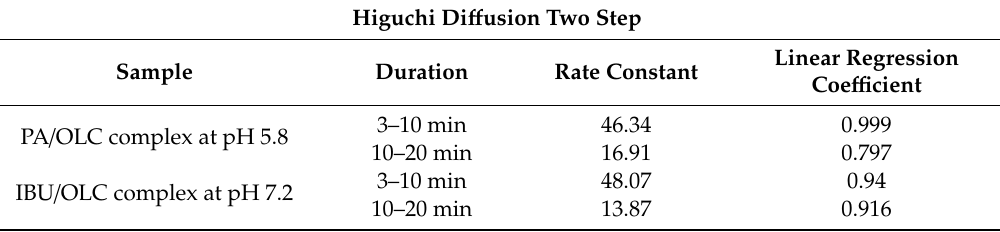
Figure 8. Two step regression linear utilising Higuchi’s square root of time plot for drug release from complex in the presence of SDS. In brackets pH of the dissolution medium. Each point represents the mean of n = 3 determinations. Table 2. Kinetic parameters of drug release from paracetamol and ibuprofen loaded carbon onion corresponding to a 2-step release with an initial burst effect during 3 to 10 min.